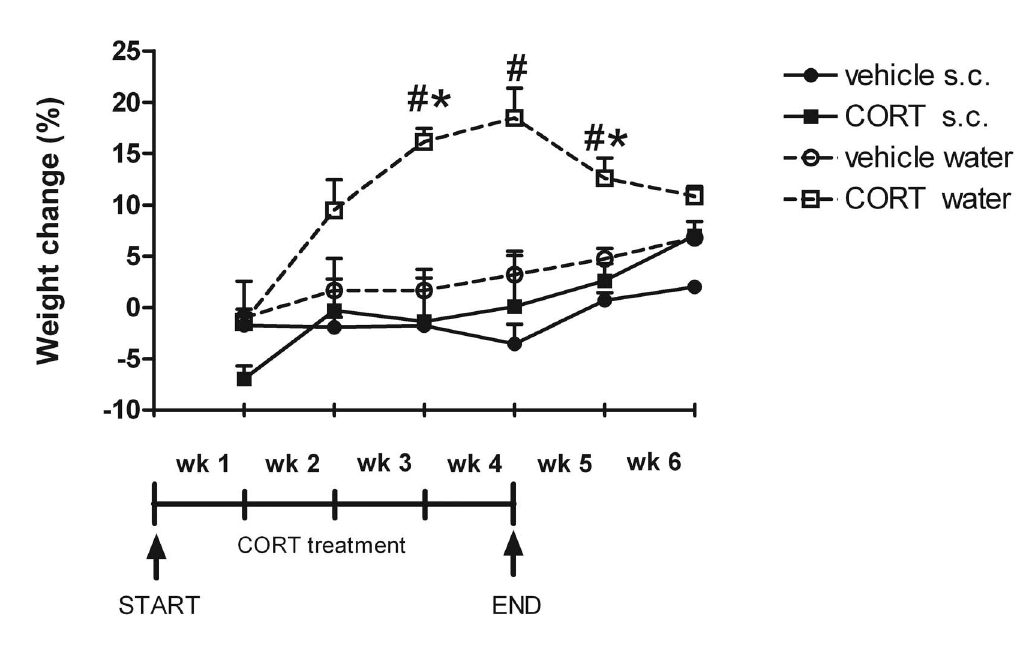
Figure 3. Effects of CORT treatment orally via the drinking water or by daily s.c. injection upon body weight (mean % change compared to body weight prior to start of treatment + S.E.M.) during the 4 week treatment period and 1 and 2 weeks after treatment cessation (week 5 and 6). The figure shows significant increased body weights in the group receiving CORT via the drinking water compared to the vehicle drinking water group ( # ) or CORT injection group (*). # /* P ,